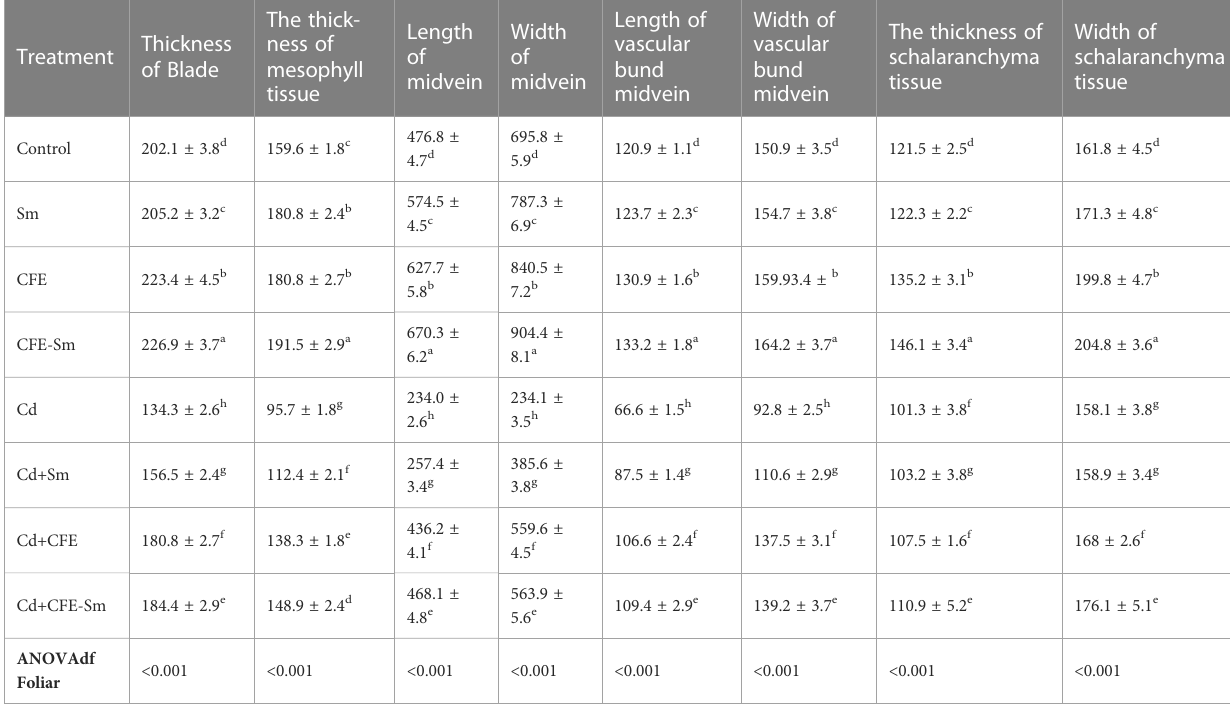
TABLE 4 Measurement in microns of certain light microscopically features of a transverse section through the leaf blade from the apex of a wheat plant (fully expanded leaf) as affected by foliar application of silymarin (Sm), clove fruit extract (CFE), or silymarin-enriched clove fruit extract (CFE-Sm) under Cd stress during the second